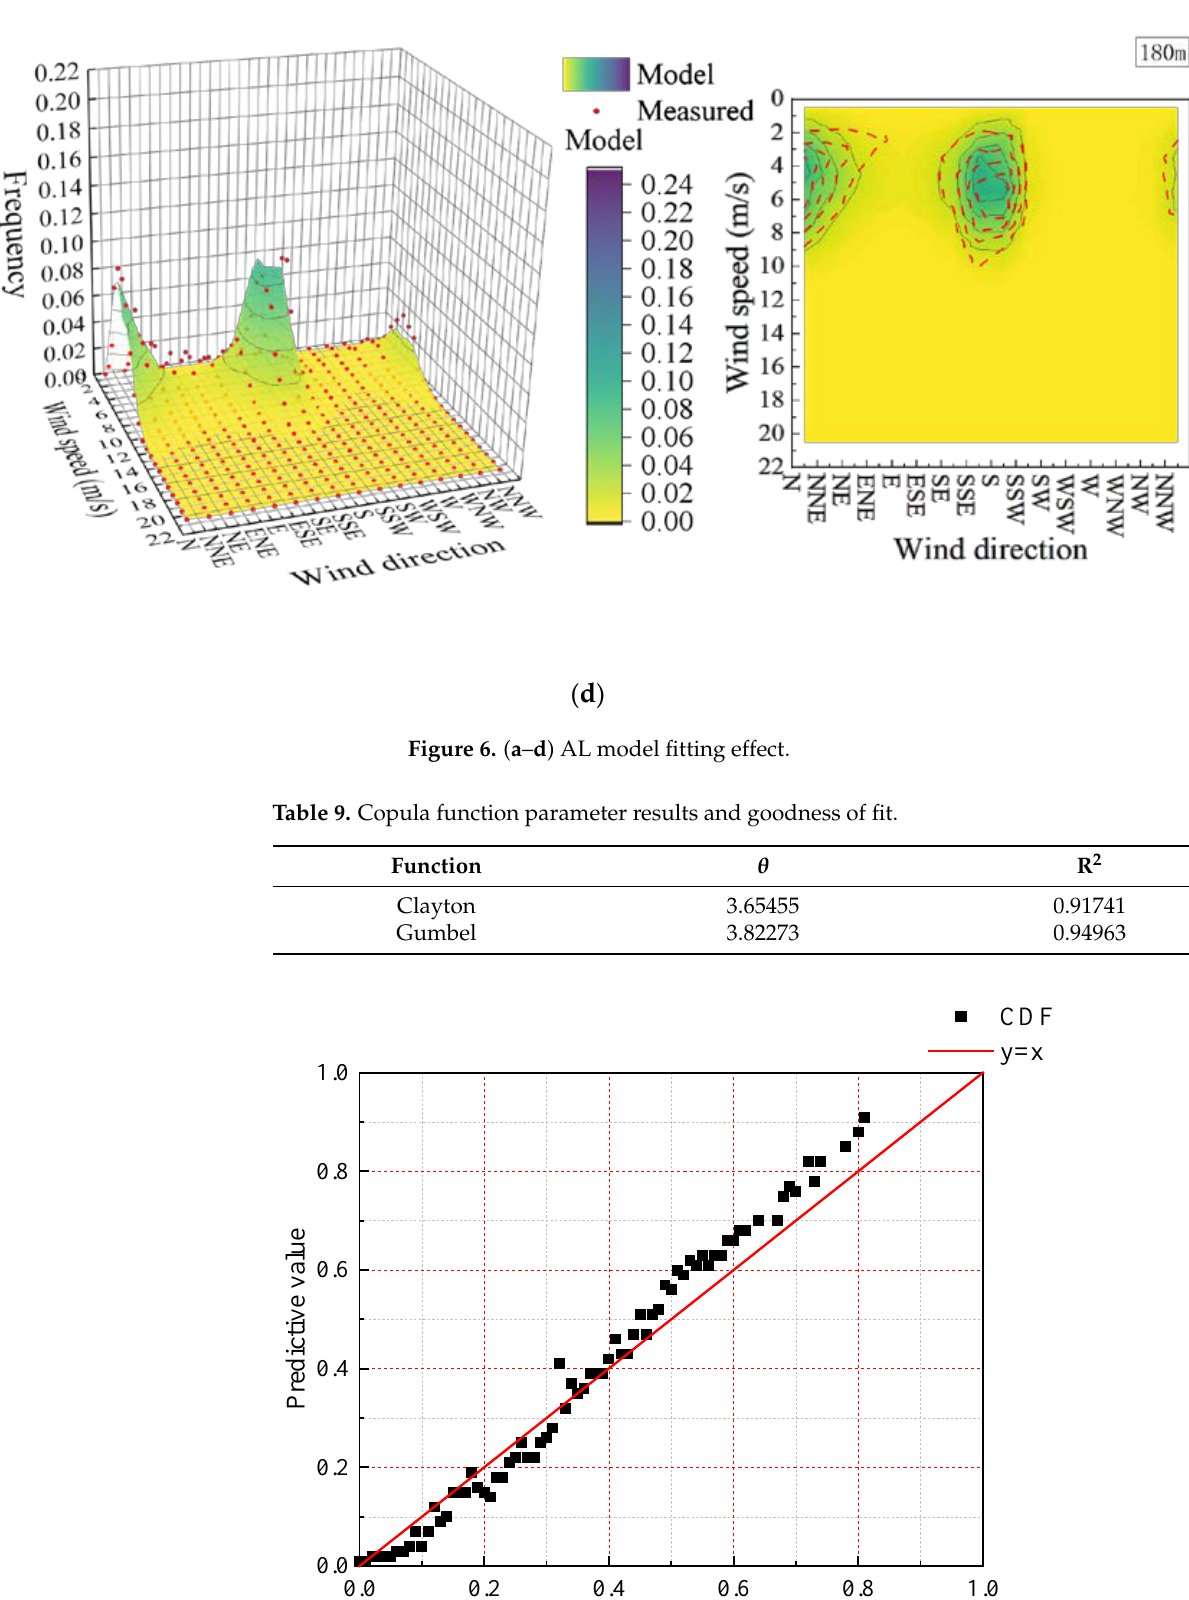
Table 9. Copula function parameter results and goodness of fit.